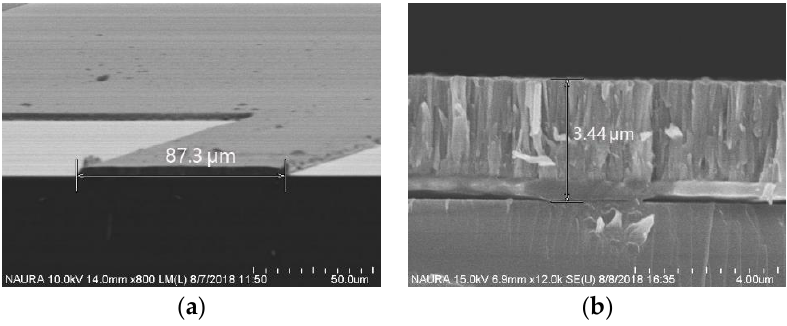
Figure 10. The quartz structure etching mask of Cr: ( a ) SEM photograph of the top view of the mask and ( b ) SEM photograph of the cross-sectional view of the mask.